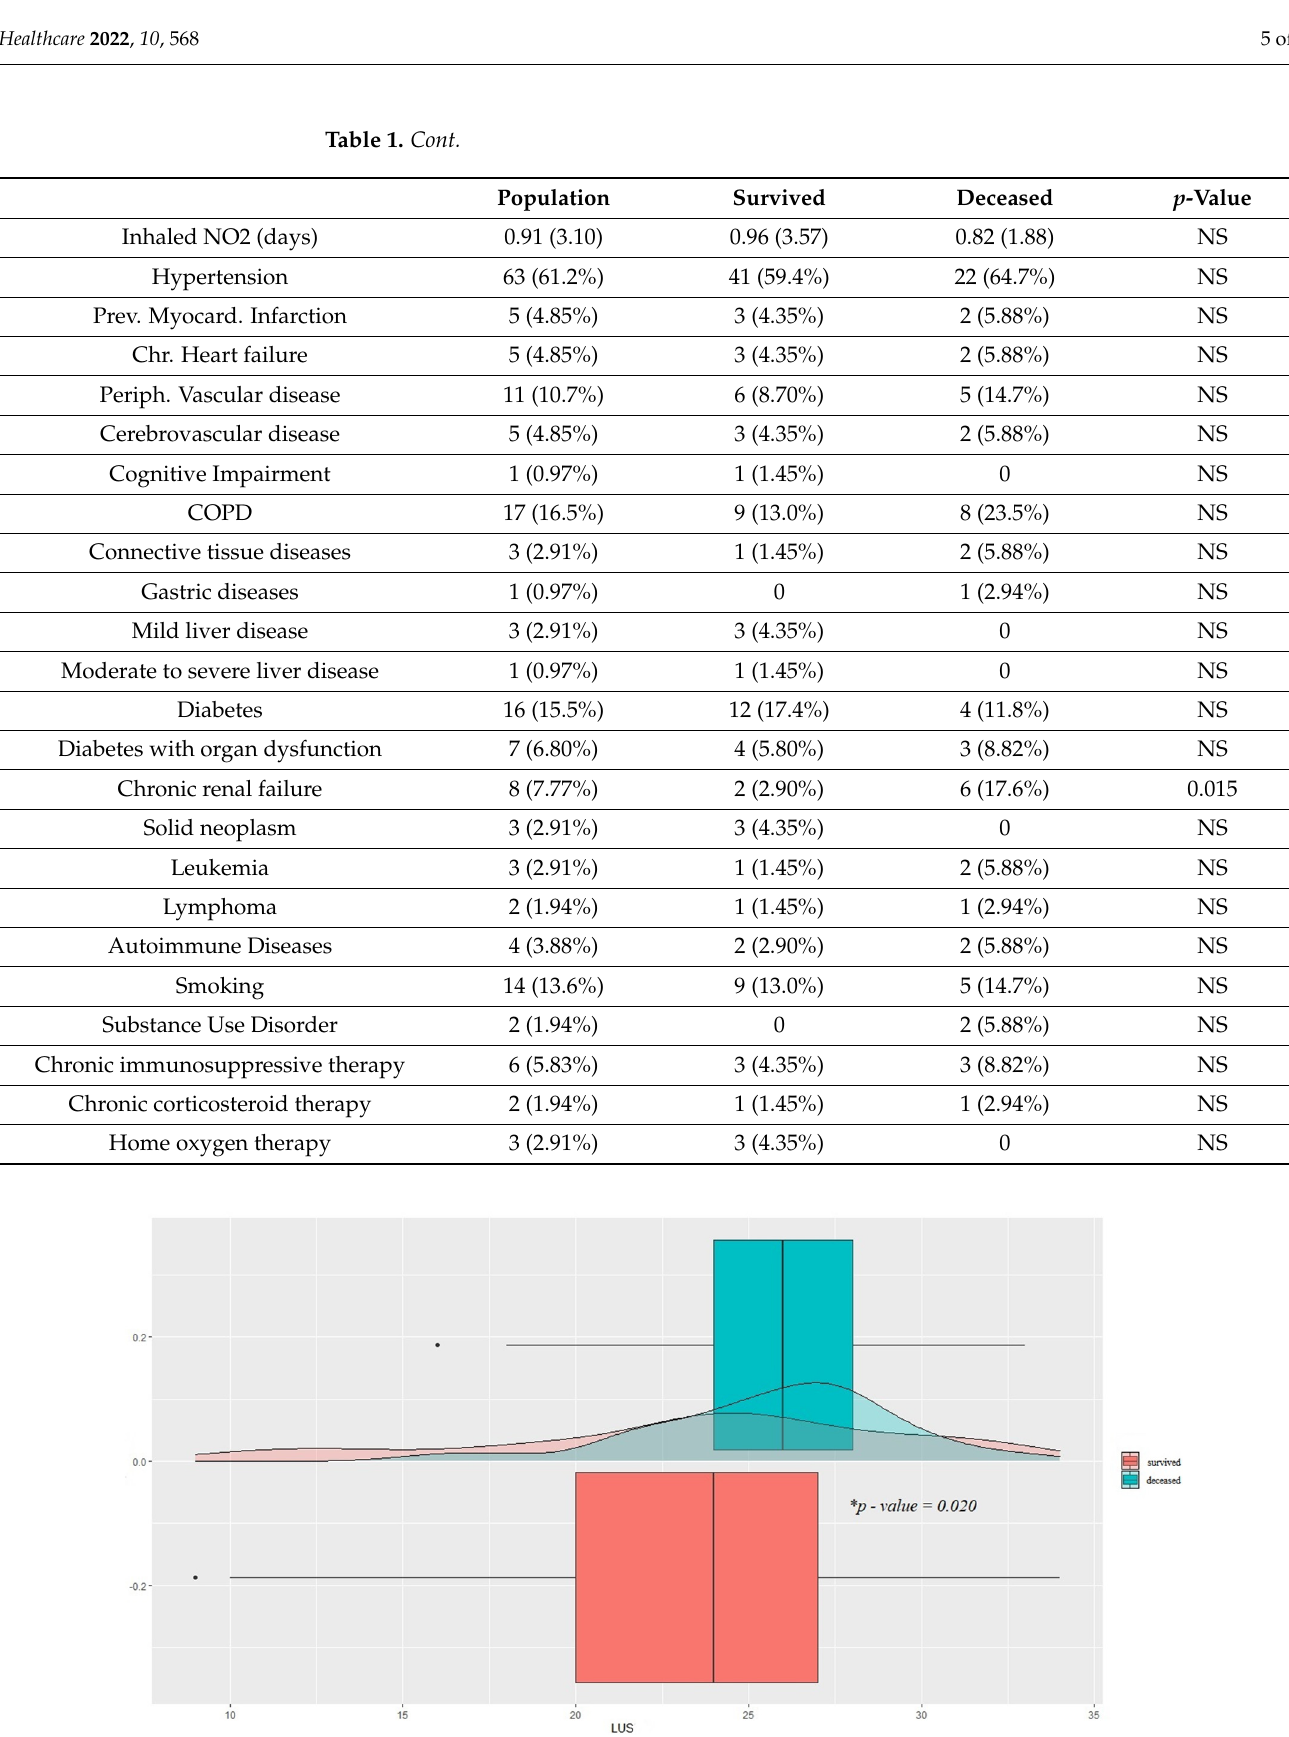
Figure 2. Comparison between LUS score distributions of surviving and deceased patients (23.5 vs. 25.7; * p = 0.02). LUS = lung